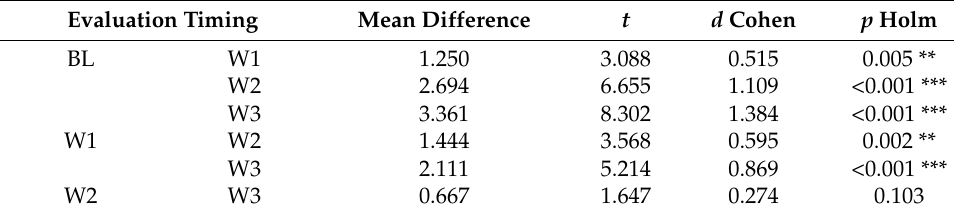
Table 7. Programme effect size on negative